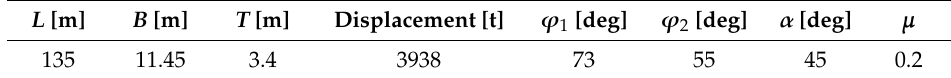
Table 6. Main particulars of the barge.